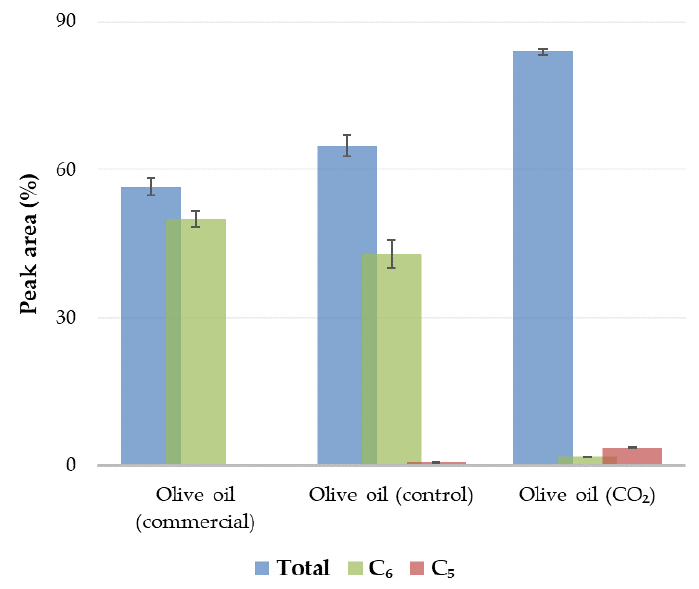
Figure 4. % Peak area of the total, C 6 , and C 5 VCs in different olive oils. Figure 4 . % Peak area of the total, C 6 , and C 5 VCs in different olive oils. 342 The quality of the oil is also directly correlated with the presence of short-chain alcohols in virgin olive oil. Since small amounts of these alcohols may occur during the ripening of olives, low levels of methanol and ethanol are acceptable. Especially, ethanol has also been detected in low concentrations [12,36,37,47]. On the other hand, significant amounts of ethanol are produced during the fermentation processes, which primarily occur during the storage of olive fruit [48,49]. Additionally, hydroxytyrosol, tyrosol, and ethanol are produced as a result of the hydrolysis of oleuropein during the preservation of olive oil [50]. During our experiments, ethanol was detected only in oil produced from CO 2 -processed olives. It had higher concentrations than reported in previous studies and the highest concentration among the VCs (50.75 ± 2.07%). Substantially, ethanol is a cellular fermentation product from continuous emissions of CO 2 in olive fruit storage